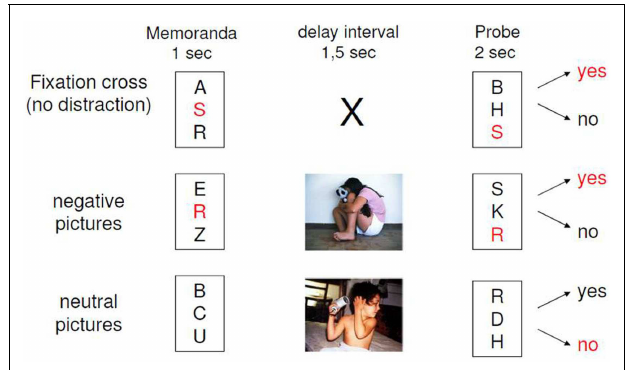
FIGURE 1 | Design of the emotional working memory task (EWMT) .